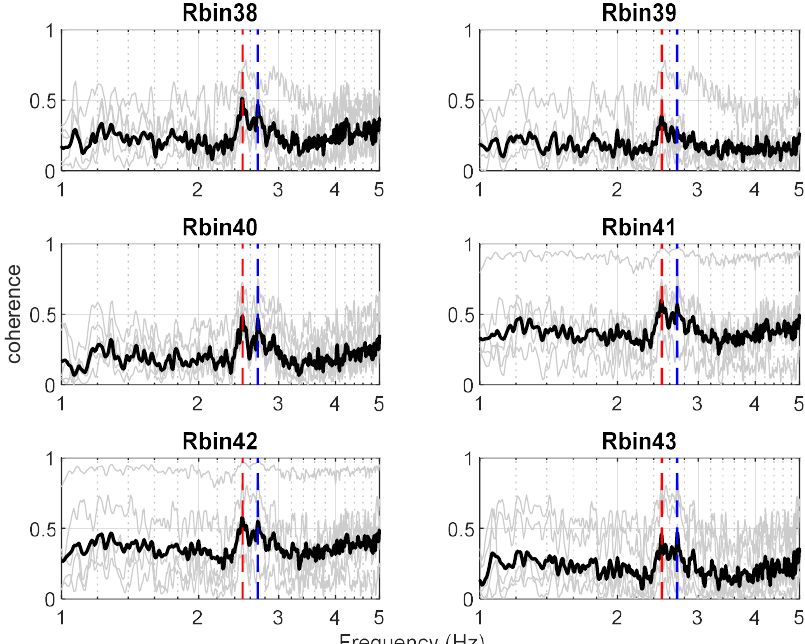
Figure 17. Mean MSCs between each Rbin signal and the array of the rest of the selected signals (black). A 1 indicates high coherence and 0 indicates no coherence at all; the grey lines indicate the different MSCs for each of the combinations of signals. The frequencies 2.49 and 2.79 Hz are indicated with red and blue dashed lines, respectively.